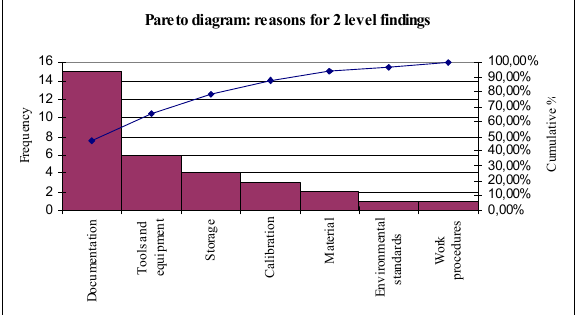
Fig 7. Pareto diagram reasons for level 2 findings in organization